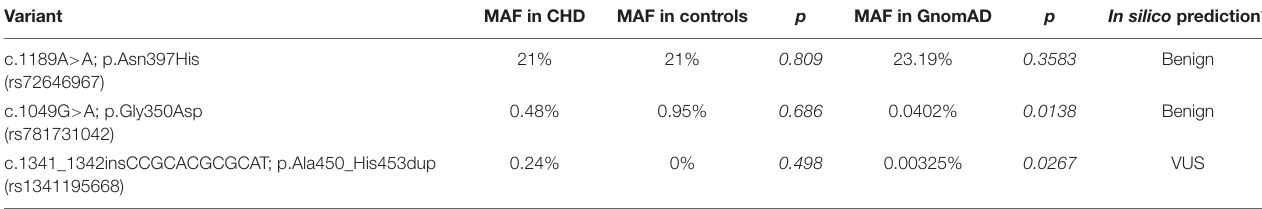
TABLE 5 | Minor allele frequencies of TBX1 variants in the CHD cohort and control cohort compared to the allele frequency in the global database.